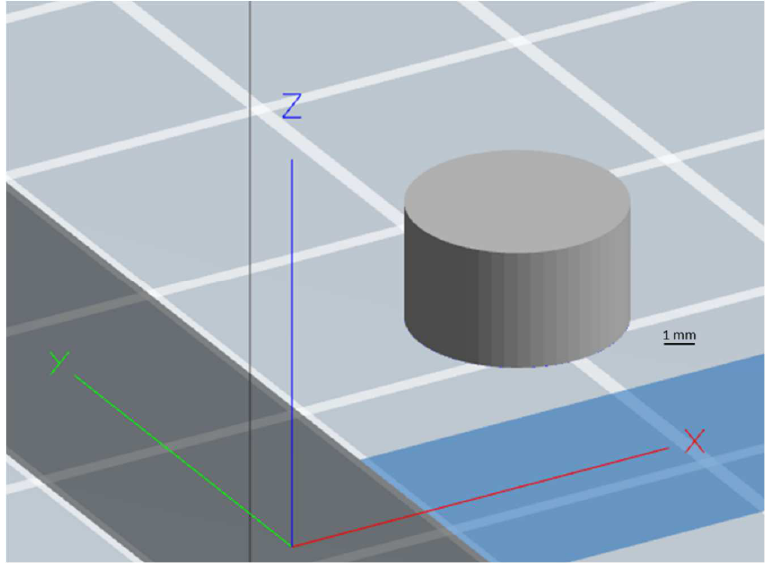
Figure 13. CAD design of the cylindrical tablet developed using SolidWorks ® version 2015.